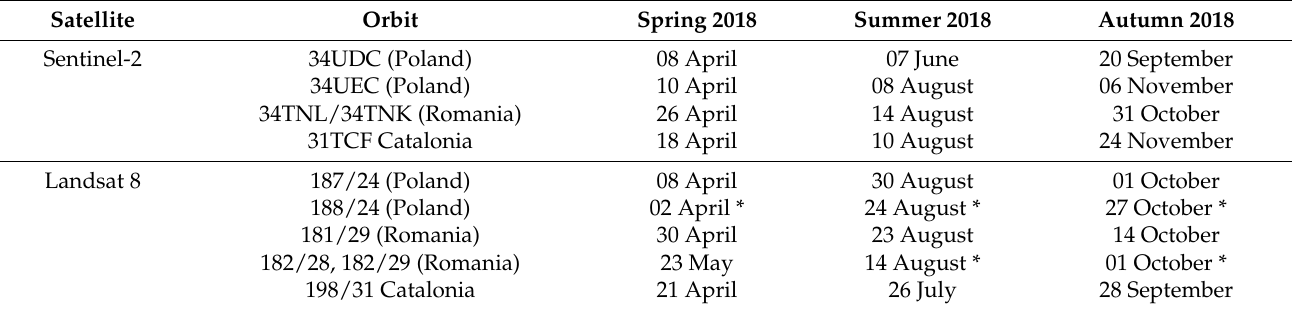
Table 2. Used satellite images